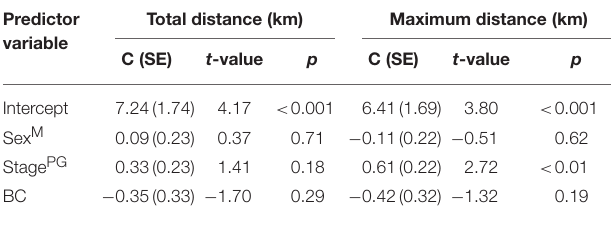
M, Coefficient representing male behavior; PG, coefficient representing the post-guard